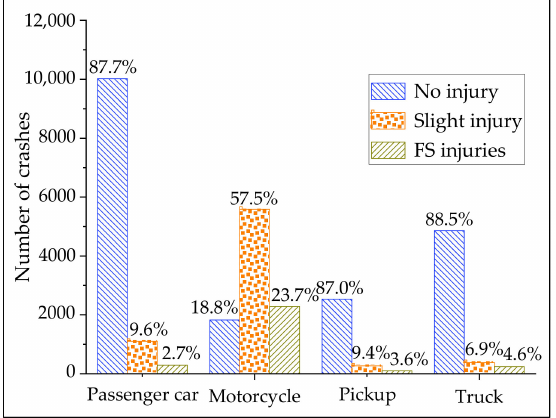
Figure 2. Statistics of crash severity by vehicle